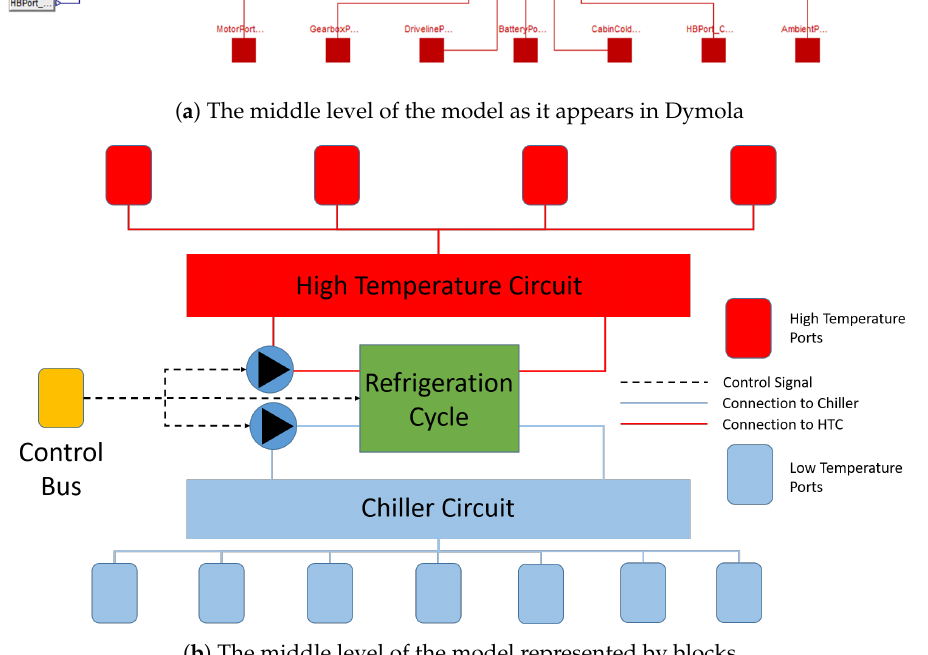
Figure 3. The middle level of the model contains the coolant circuits and the refrigeration loop and is used to control coolant flow between